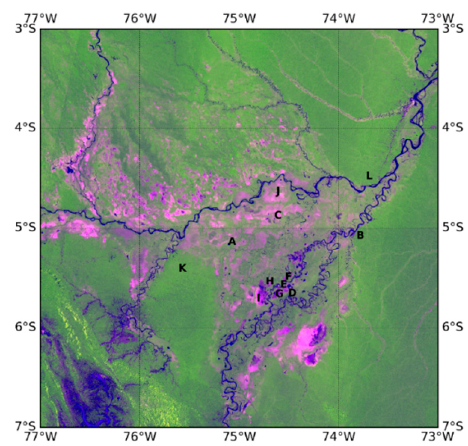
Figure 3. Two-step classification scheme used to classify static maximum flooded extent and dynamic land cover types and flooding status. The decision tree was implemented with thresholds derived from ROIs corresponding to associated homogenous land cover classes.